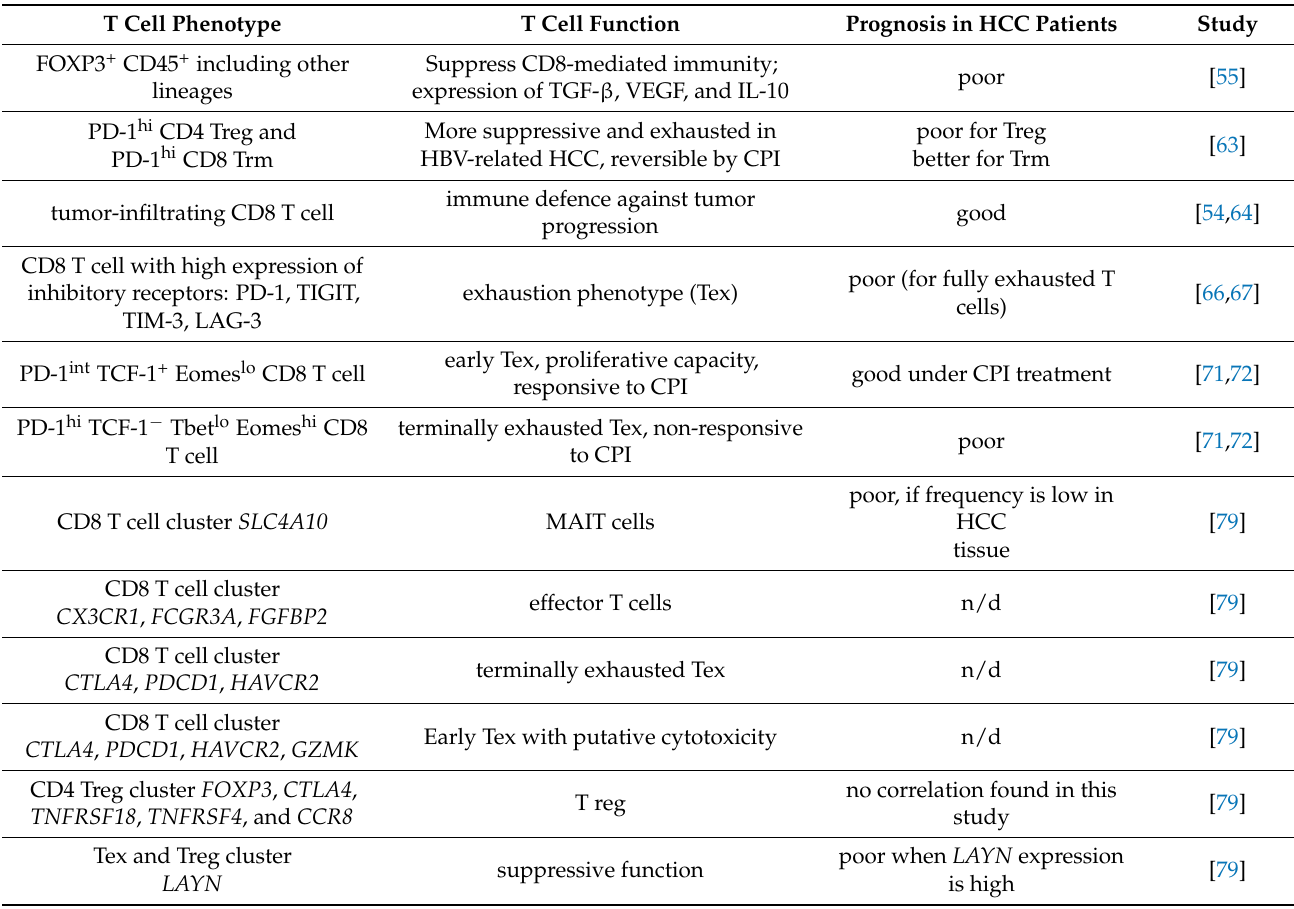
Table 1. Overview of T cell phenotypes in HCC